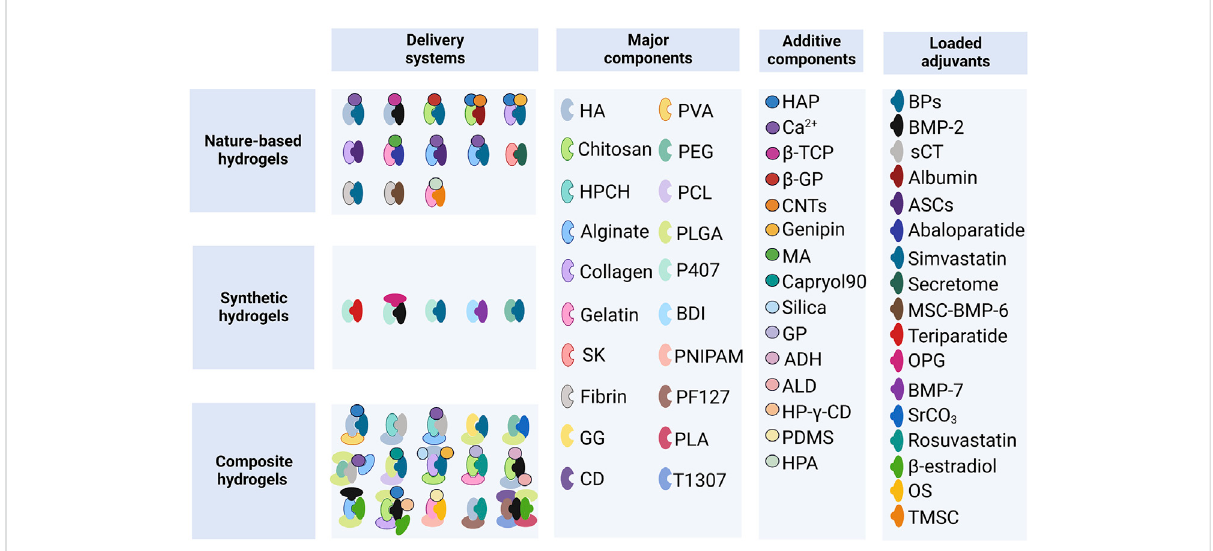
FIGURE 2 Hydrogel-based delivery systems. HA, hyaluronic acid; PVA, polyvinyl alcohol; HPCH, hydroxypropyl chitin; PEG, polyethylene glycol; PCL, polycaprolactone; SK, silk fi broin; GG, gellan gum; PLGA, poly (lactic-co-glycolic acid); P407, Poloxamer 407; BDI, butane-diisocyanate; PNIPAM, poly (N-isopropylacrylamide); PF127, Pluronic F127; T1307, Tetronic 1307; CD, α -cyclodextrin; PLA, poly-lactic acid; HAP, hydroxyapatite; β -TCP, β - tricalcium phosphate; β -GP, β -glycerophosphate; CNTs, carbon nanotubes; MA, methacrylic anhydride; GP, glycerophosphate; ADH, adipic acid dihydrazide; ALD, aldehyde; HP- γ -CD, 2-hidroxipropil γ -cyclodextrin; PDMS, polydimethylsiloxane; HPA, hydroxyphenyl propionic acid; BPs, bisphosphonates; BMP-2, bone morphogenetic protein-2; sCT, salmon calcitonin; ASCs, adipose-derived stem cells; MSC-BMP6, porcine mesenchymal stem cells overexpressing the BMP6 gene; OPG, osteoprotegerin; BMP-7, bone morphogenetic protein-7; OS, ovarian spheroids; TMSC, tonsil-derived mesenchymal stem